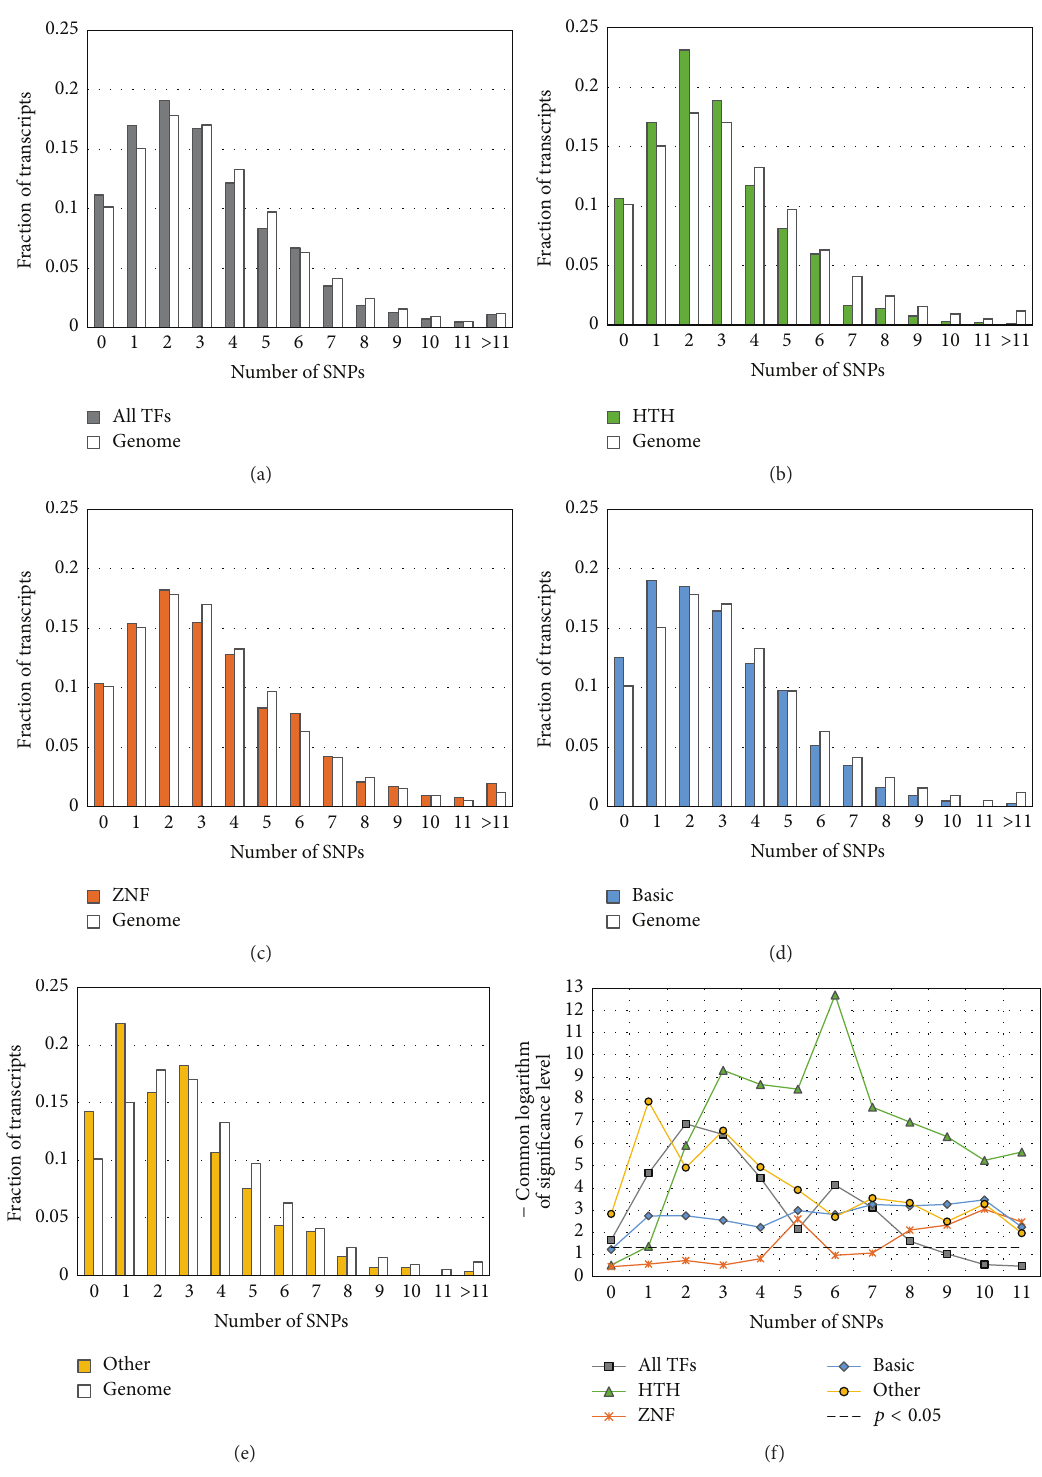
Figure 3: Comparison of SNP content distributions in upstream regions for human genes encoding transcription factors with the distribution in the whole-genome dataset (Table 1). The 5 󸀠 -regulatory regions between − 600 and +100bp around TSSs are analyzed. The datasets of transcripts/genes (Table 1) are derived from TFClass [9]: (a) all transcription factors, (b) helix-turn-helix factor genes, (c) transcription factors with zinc-coordinating DBDs, (d) basic domain factor genes, and (e) genes encoding factors with DBDs of all other types. In panels (a) to (e) the 𝑥 -axis denotes the SNP content; the 𝑦 -axis means the fraction of transcripts with specific content of SNPs in their 5 󸀠 -regulatory regions. Panel (f) presents the significance of the 𝑡 -test ( 𝑦 -axis), which compare the above-described SNP contents in test groups with the content in the whole-genome dataset as a function of the threshold of SNP content ( 𝑥 -axis). The 𝑡 -test was applied as described in Section